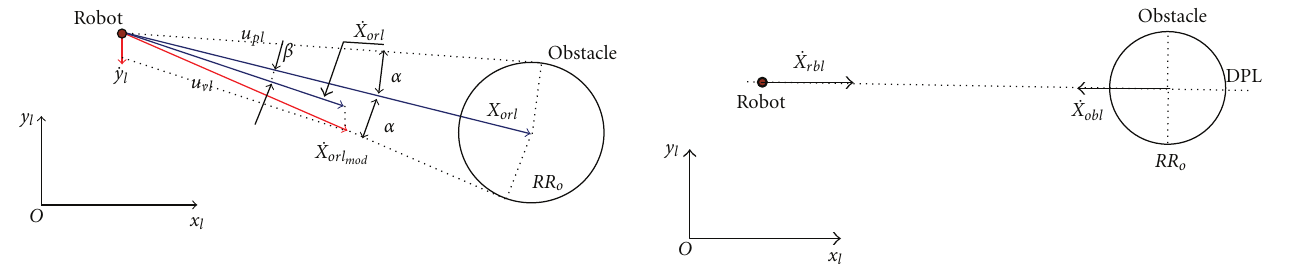
Figure 9: Changing ˙ y l in obstacle avoidance.